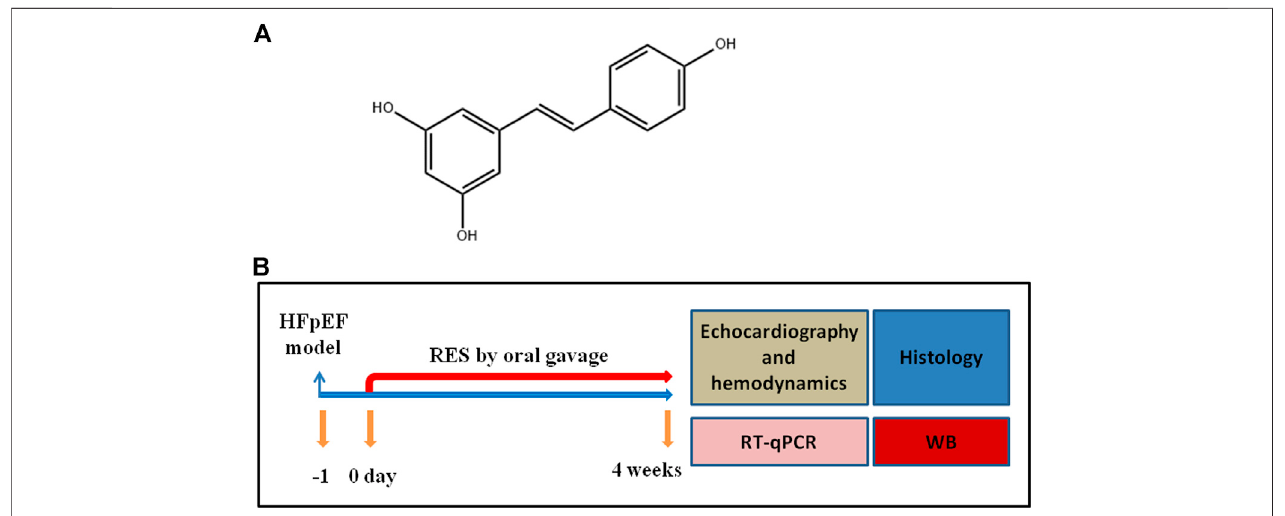
FIGURE 1 | (A) Structure of RES. (B) Experimental protocol for HFpEF mice administered vehicle or resveratrol (RES).